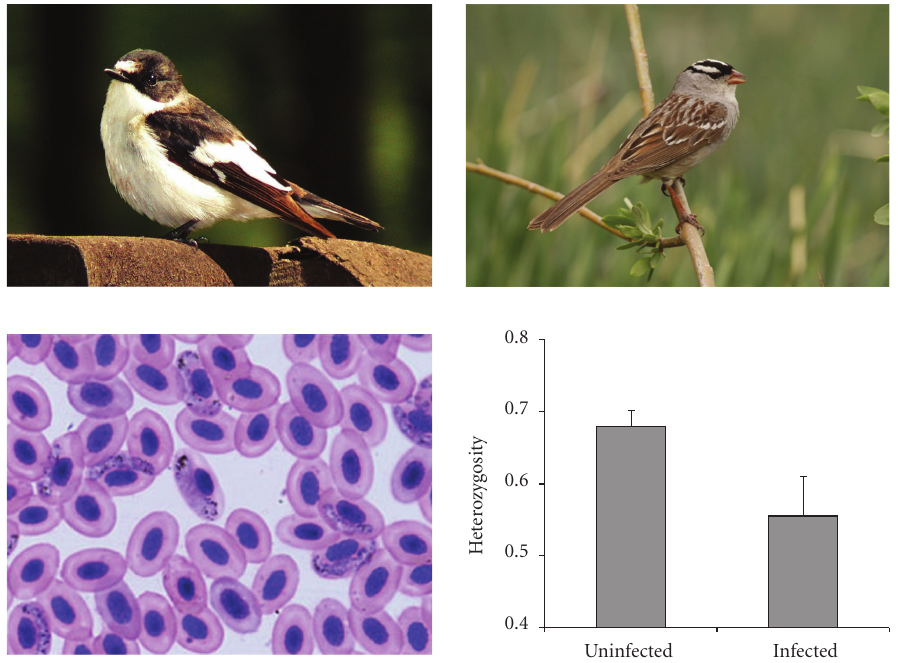
Figure 3: Top left: in the hybrid zone between pied flycatcher ( Ficedula hypoleuca ) and collared flycatcher ( Ficedula albicollis ) hybrids showed intermediate prevalence of Haemoproteus blood parasites compared to the parental species, and also intermediate immune responses to infection [74] (photo shows a male hybrid F. hypoleuca × F. albicollis, courtesy of Miroslav Kr´al). Bottom left: haematozoan blood parasites can be agents of severe selection in birds (photo shows Haemoproteus multipigmentatus infecting red blood cells of endemic Gal´apagos doves [84], courtesy of Gediminas Valkiunas). Right panels: in the mountain white-crowned sparrows ( Zonotrichia leucophrys oriantha ) heterozygote advantage in terms of reduced parasite load may counteract elevated parasitism of immigrants, who are likely to produce the most heterozygous o ff spring [75] (photo courtesy of Bob Steele). Figure reproduced with permission of the Royal Society of London from MacDougall-Shackleton et al. [75].